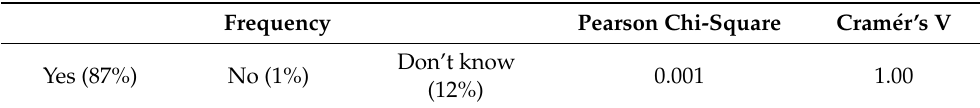
Table 10. refer back to Figure 3. Frequency * Vulnerability to_ women, children, the elderly and the disabled are most vulnerable to climate change- Cross